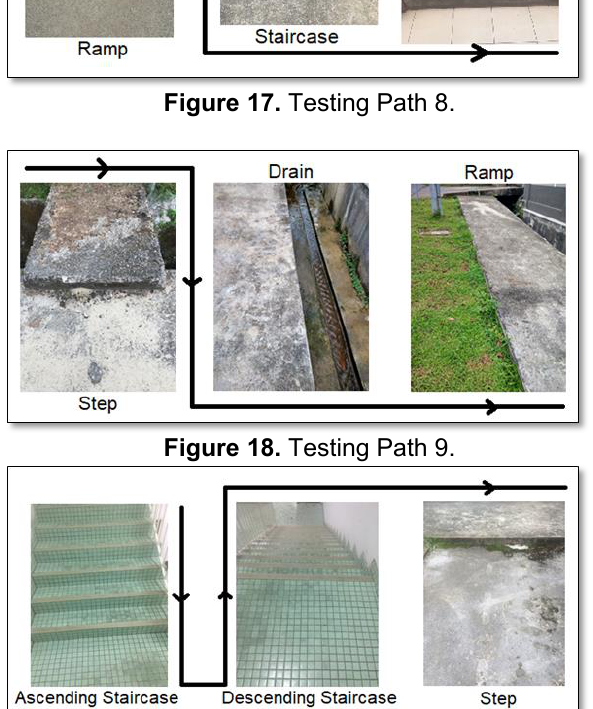
Figure 19. Testing Path 10.